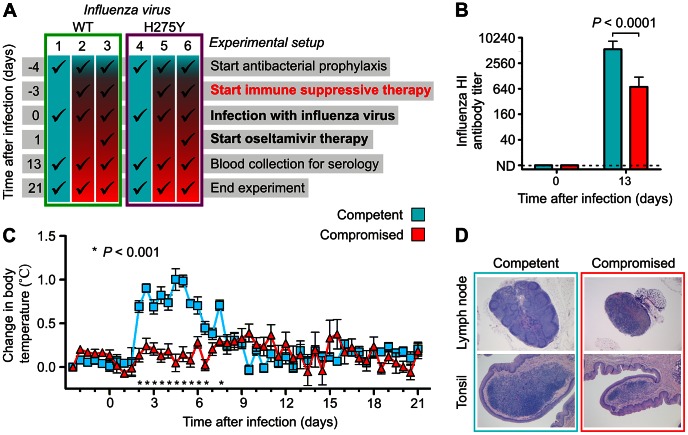
Ferrets on immune suppressive therapy show defective immune function.(a) Schematic of the experimental setup in which 6 groups of ferrets (n = 6) were infected on day 0 with wild type (WT; groups 1–3; green) or oseltamivir resistant (H275Y) mutant virus (groups 4–6; magenta). Three days before, immune suppressive therapy was started and added to the antibacterial cocktail of groups 2, 3, 5 and 6. Oseltamivir therapy was added to the drug regime of groups 3 and 6, 24 hours after infection. (b) Reduction of pH1N1 virus specific serum hemagglutination inhibiting (HI) antibody titers in the remaining (n = 14) immunocompromised ferrets compared to control (n = 12) ferrets. Data are mean ± s.e.m. The P value was calculated by Mann-Whitney U test. (c) Body temperature profiles show the absence of body temperature rise during the acute stage of infection in immunocompromised ferrets. Data are mean ± s.e.m. The P value was calculated by unpaired Student's t test. (d) Lymphoid tissues show deficient lymphoid follicle formation in lymph nodes and lymphocyte depletion in the tonsils of immunocompromised ferrets. Representative photomicrographs of tracheobronchial lymph nodes (original magnification 25×) and tonsils (original magnification 50×). Tissues were stained with hematoxylin and eosin (H&E).